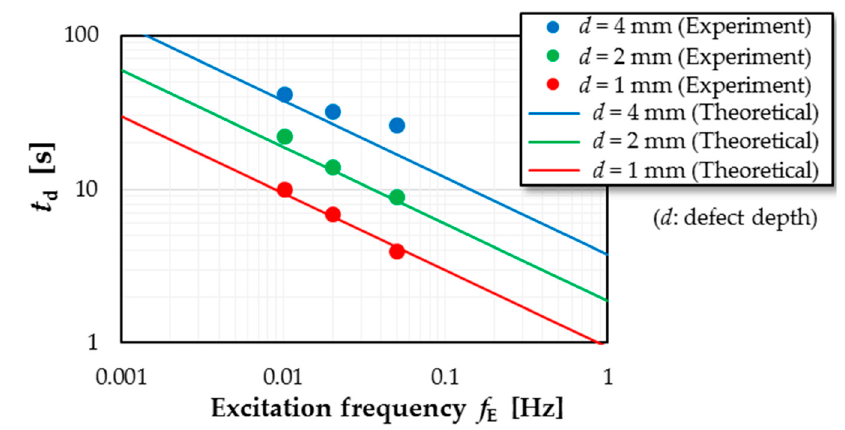
Figure 2. Experimentally obtained relationship between time required for detecting each depth defect ( t d ) and excitation frequency ( f E ). Theoretically estimated t d s (calculated as round-trip time of thermal wave propagation between CFRP surface and defect) are presented as solid lines.